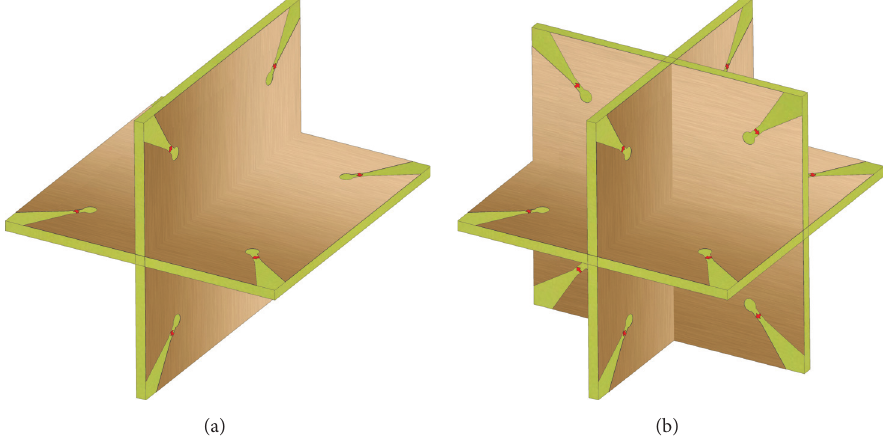
Figure 7: The antenna system arrangements with (a) 8 elements and (b) 12 elements.